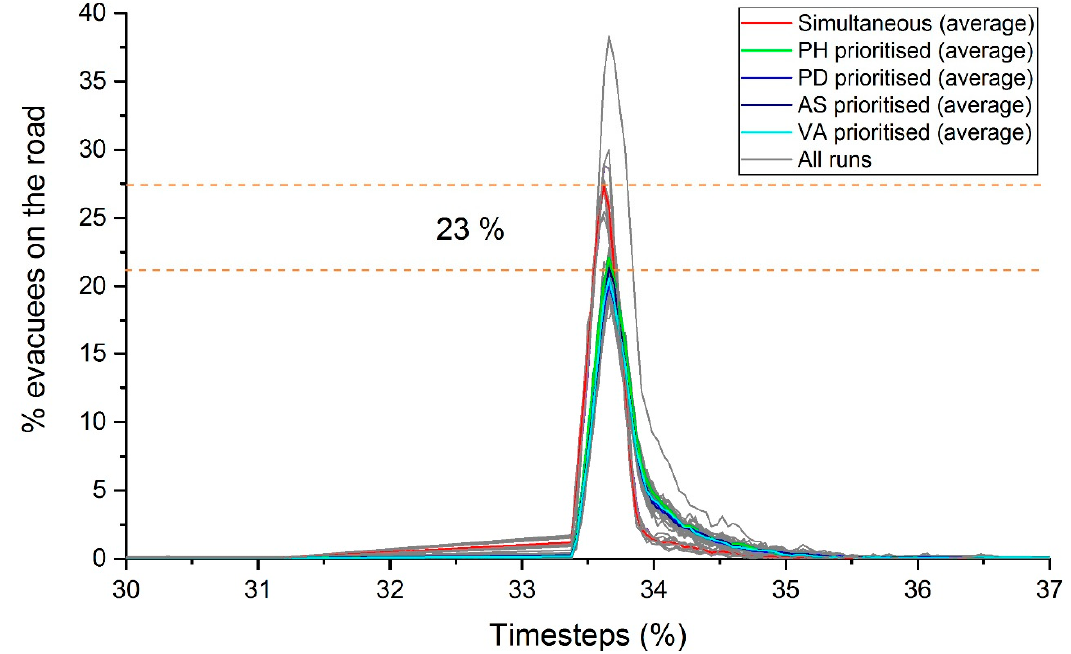
Figure 9. Comparison of the percentage of evacuees on the road during the peak evacuation time.